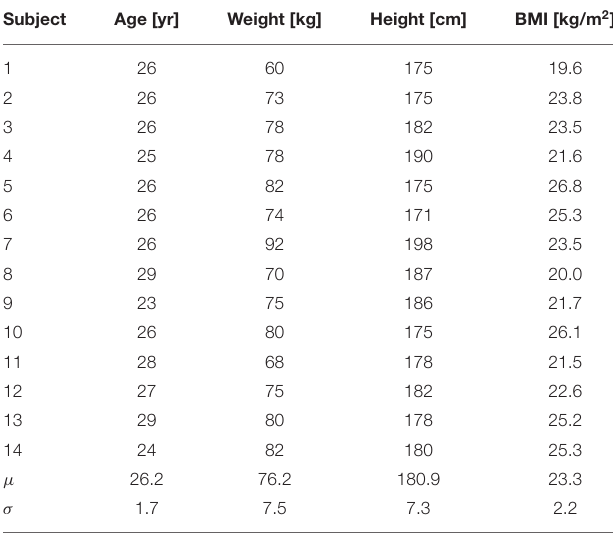
TABLE 1 | Anthropometric features of subjects (BMI is the body mass index, computed as Weight/Height 2 , whereas µ and σ denote the mean and SD